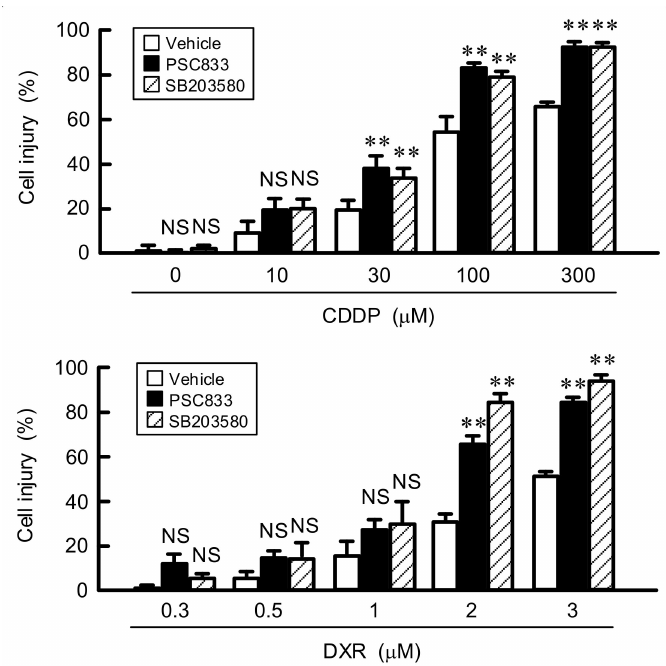
Figure 7. Rescue of LM-induced chemoresistance by PSC833 and SB203580. A549 cells cultured with LM were pre-treated with vehicle (dimethyl sulfoxide), 10 µ M of PSC833, or 10 µ M of SB203580 for 24 h. Then, the cells were incubated with CDDP and DXR at the concentration indicated for 24 h. Cell injury was measured using the Premix WST-1 Cell Proliferation Assay System. n = 6–8. ** p < 0.01 compared with vehicle. NS, p >